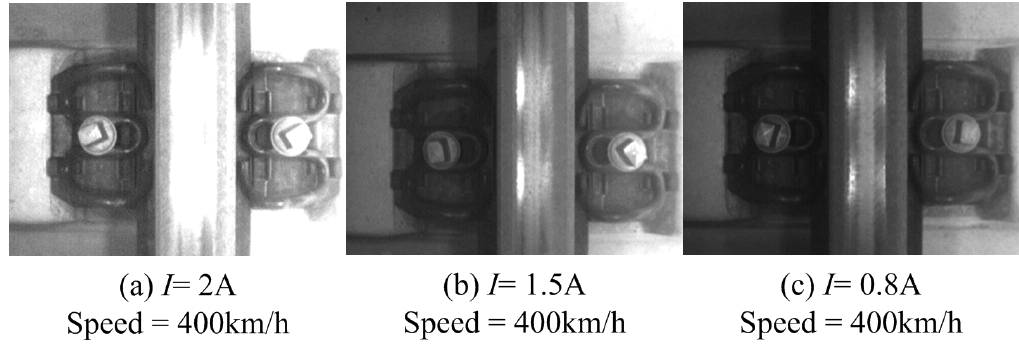
Figure 17. Practical images of fasteners at 400 km/h.